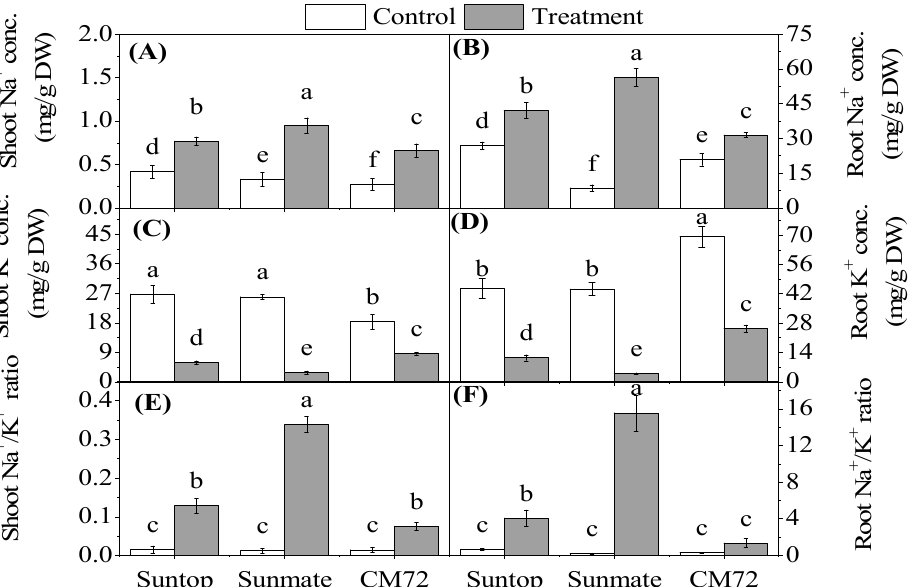
Figure 3. E ff ect of salinity stress on Na + and K + concentrations and Na + :K + ratio in shoots ( A , C , E ) and roots ( B , D , F ) of two wheat cv., Suntop and Sunmate, and the barley cv., CM72, 25 days after treatment with 100 mM NaCl. Error bars represent SE ( n = 4). Di ff erent letters indicate significant di ff erences ( p ≤ 0.05) among the 3 cultivars.